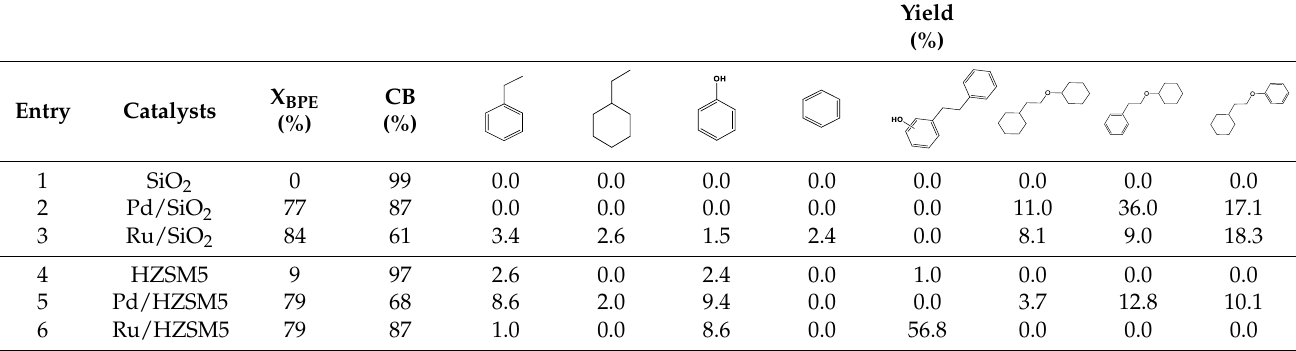
Table 4. Conversion of PEB, carbon balance, and product distribution for Ru- and Pd-based catalysts.